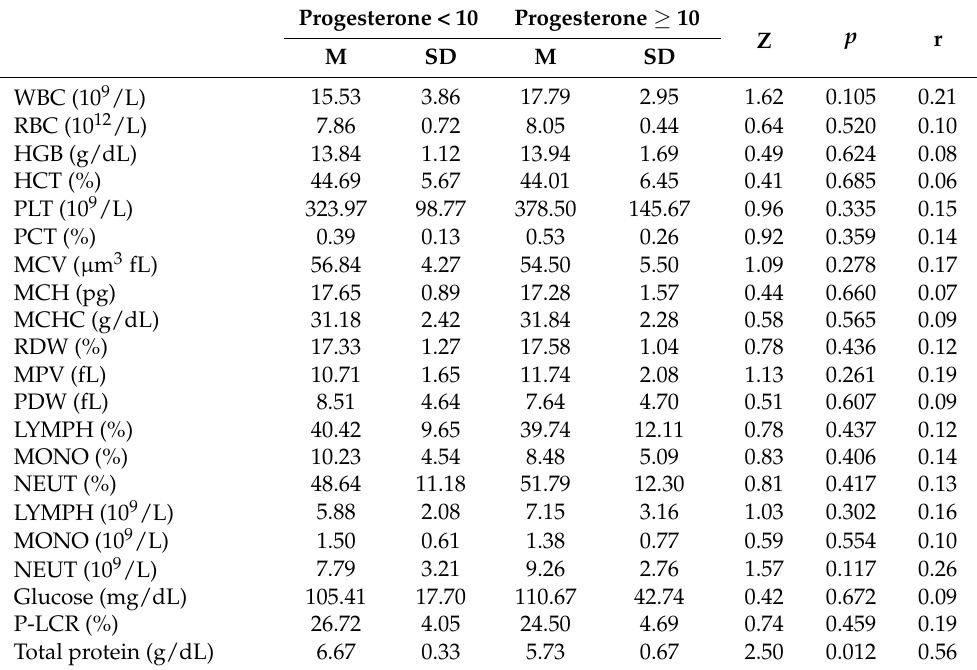
Table 1. Influence of progesterone level (ng/mL) on selected haematological and biochemical blood parameters of